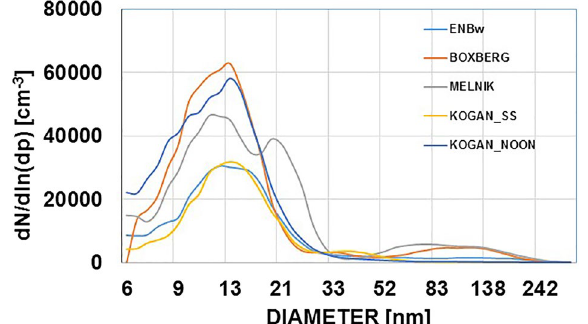
Figure 1. Aerosol size distributions measured ~ 1 h downwind of coal fired power stations (lignite and hard coal). Light blue: ENBw, Karlsruhe, July 2007; Orange: Boxberg, Eastern Germany, June 2014, both within the well mixed PBL at ~ 600 to 800 m AGL., Grey: Melnik, CZ observed early morning over Eastern Germany after 130 km nocturnal transport in the lower free troposphere > 600 m AGL, June 10, 2014, above a strong temperature inversion at ~ 550 m AGL. Yellow: Kogan Creek, Queensland, Australia at sunset (SS) and blue (noon, /2) the next day 25./26.8.2012, all within the mixed planetary boundary layer ~ 300 to 500 m AGL